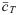
Plot of the function f(ci) for different values of the c¯T concentration.a) At low concentrations there is a single fixed point. b) At higher concentrations two extra unstable fixed points appear. c) At high concentrations the upper fixed point becomes stable.